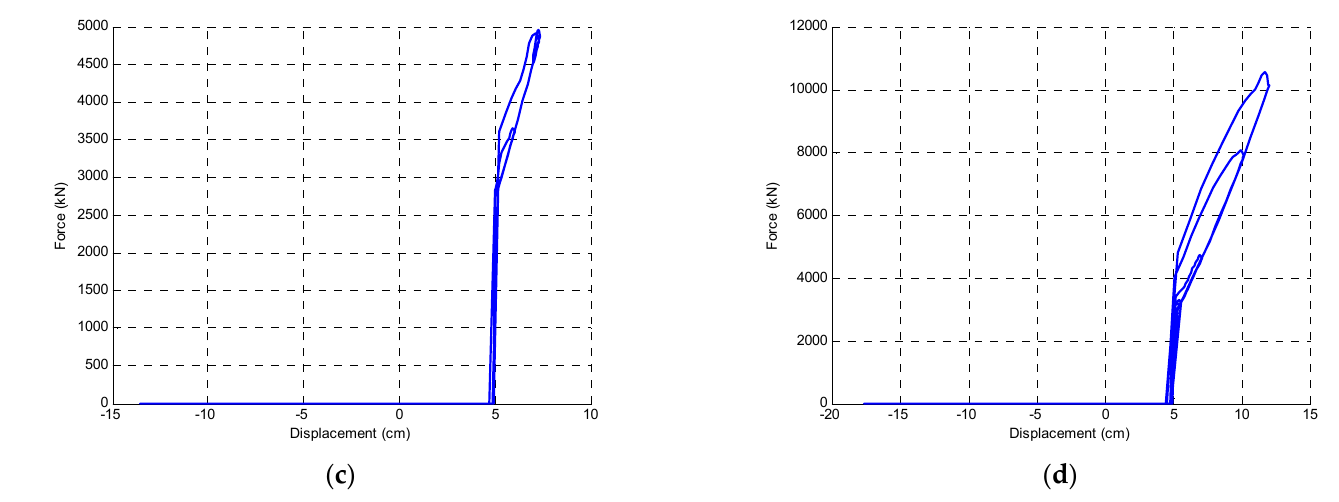
Figure 11. Hysteresis loops determined for the model under different earthquake excitations: ( a ) Parkfield; ( b ) Kobe; ( c ) San Fernando; ( d ) Tabas.